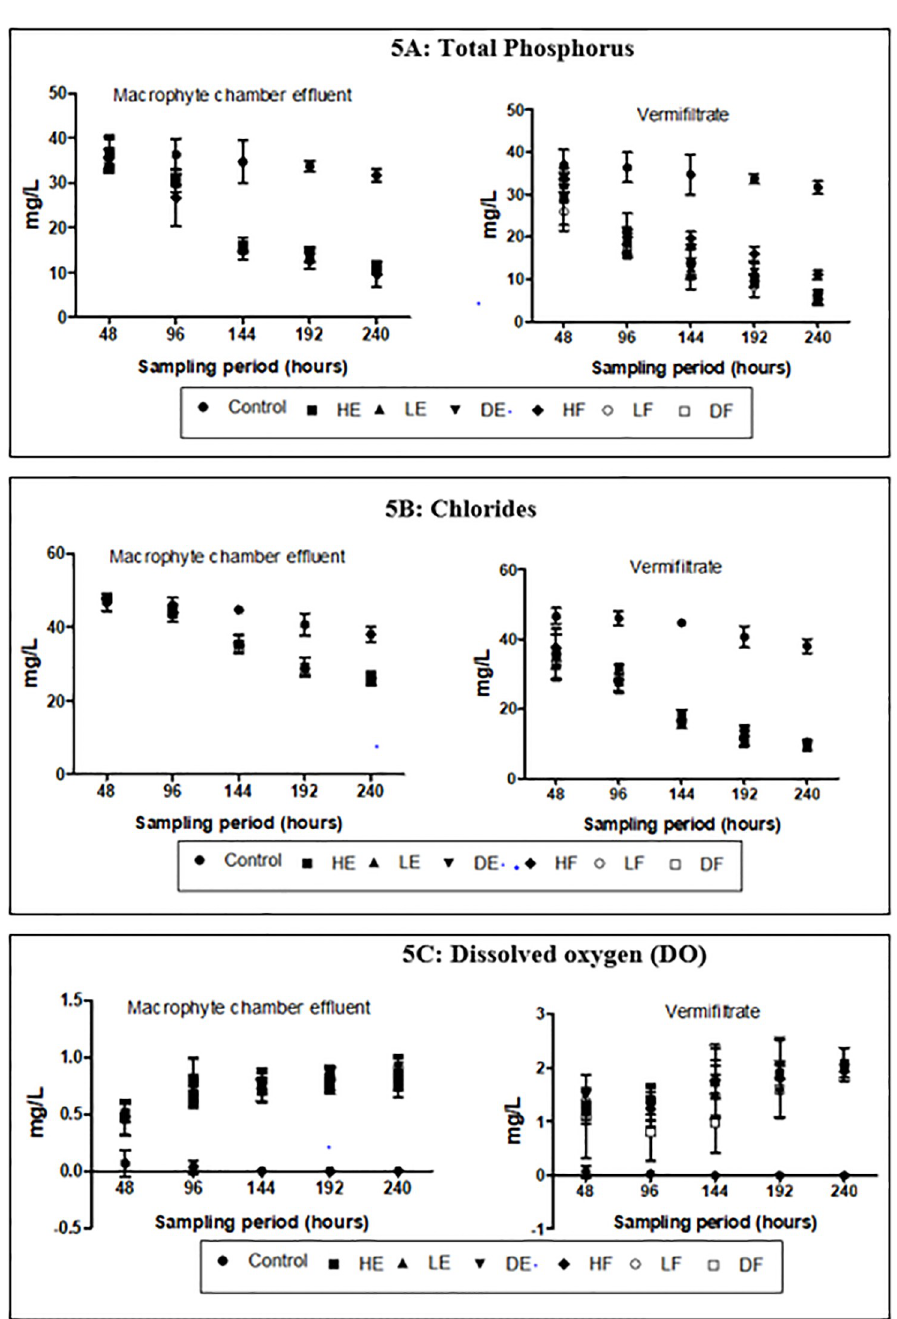
Fig 5. Physicochemical characteristics of effluent (A) Total phosphorus (B) Chlorides (C) DO. control demonstrated 13.25%, 76.28%, 32.37% and 15.33% reductions in N and P respectively. These percentage reductions in the control were the least recorded when tot compared to the effluents from the experimental treatments. The percentage reductions of N in the macrophyte chamber and vermifiltration effluents were 58%– 60% and 71%– 77% tot respectively, NH were 71%– 77% and 92%– 98% respectively, NO 3